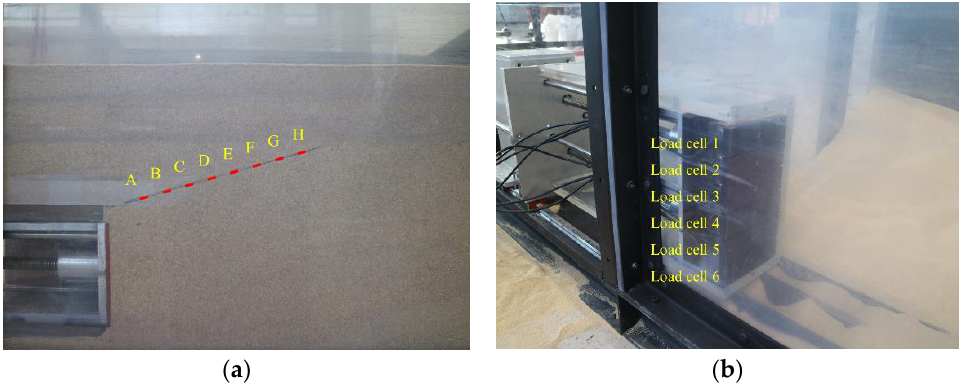
Figure 6. Measuring system: ( a ) strain gauges on pile. ( b ) Load cell on pressure panel. Table 6. Point on pile of each strain gauge.